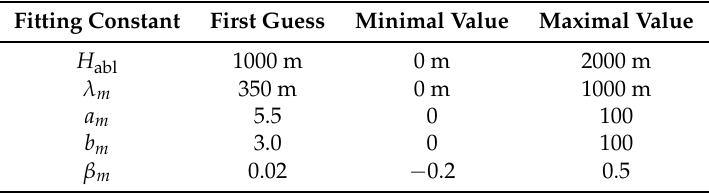
Table 2. First guess and bounds for the fitting constants in Equation